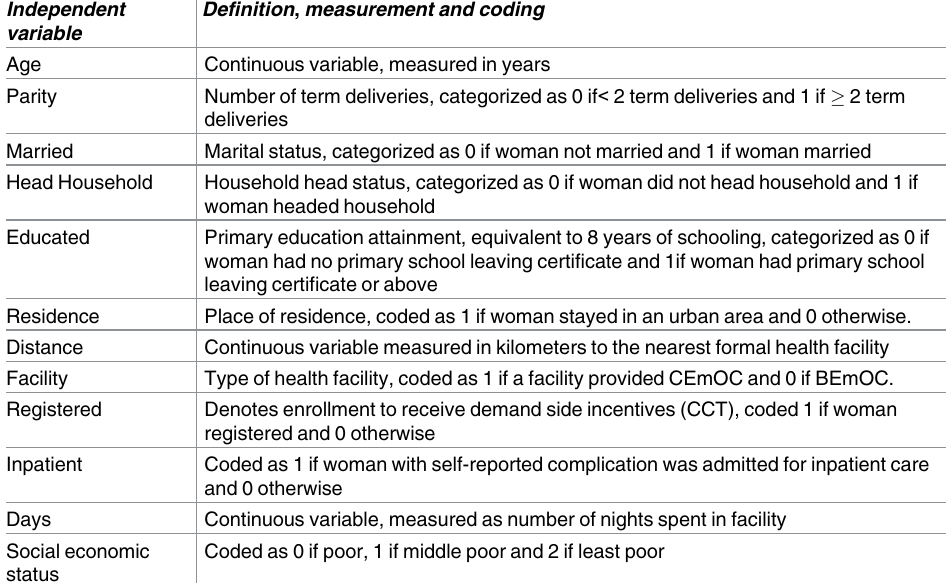
Table 1. Independent variables definitions and